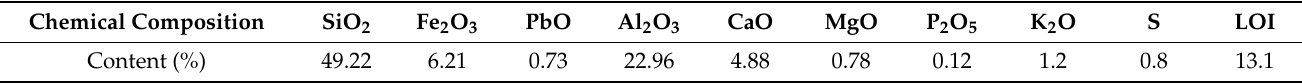
Table 2. Chemical components of coal